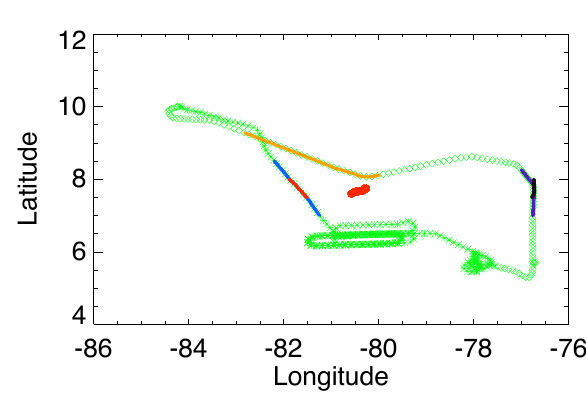
Fig. 7. DC-8 flight path with green stars marking the flight path prior to 17:17UTC and the green diamonds marking the flight path Figure 7. DC-8 flight path with green stars marking the flight path prior to 1717 UTC and the 3 after 17:17UTC. The colored dots superimposed on the flight path green diamonds marking the flight path after 1717 UTC. The colored dots superimposed on 4 correspond to DC-8 DIAL measurement locations, with the color- the flight path correspond to DC-8 DIAL measurement locations, with the color-coding to 5 coding to match the profiles seen in Fig. match the profiles seen in Fig. 6. 6